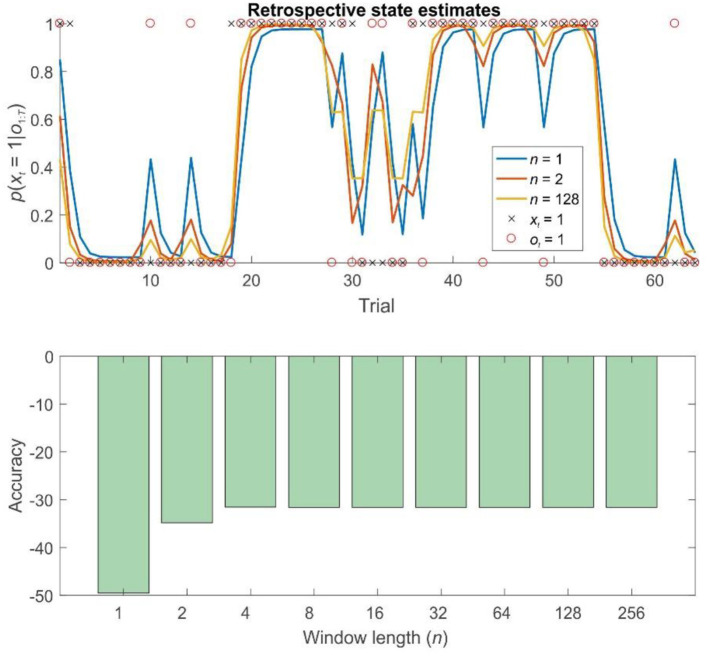
Retrospective belief updating improves state estimates during pure inference on a probabilistic reversal task. Top panel: illustration of the first 64 trials of a 256 trial session of the reversal task using different strategies. The final (retrospective) posteriors are shown in blue (n = 1, filtering), orange (n = 2), and gold (n = 128). Black crosses show the true hidden state, and red circles the observations made on each trial. Retrospective belief updating allows agents to infer the true underlying states more accurately. Bottom panel: relative log accuracy of models of different window lengths, averaged across simulated time series (see main text for details) (Accuracy is quantified as the log likelihood assigned to the true sequence of states by the agent, averaged across simulations). This illustrates that, in this context at least, even the use of a very short window leads to significantly more accurate beliefs, but that this benefit saturates relatively rapidly (by about n = 8). Thus, for a bounded rational agent performing pure inference, the optimal window length may be surprisingly low, depending on the relevant computational costs.